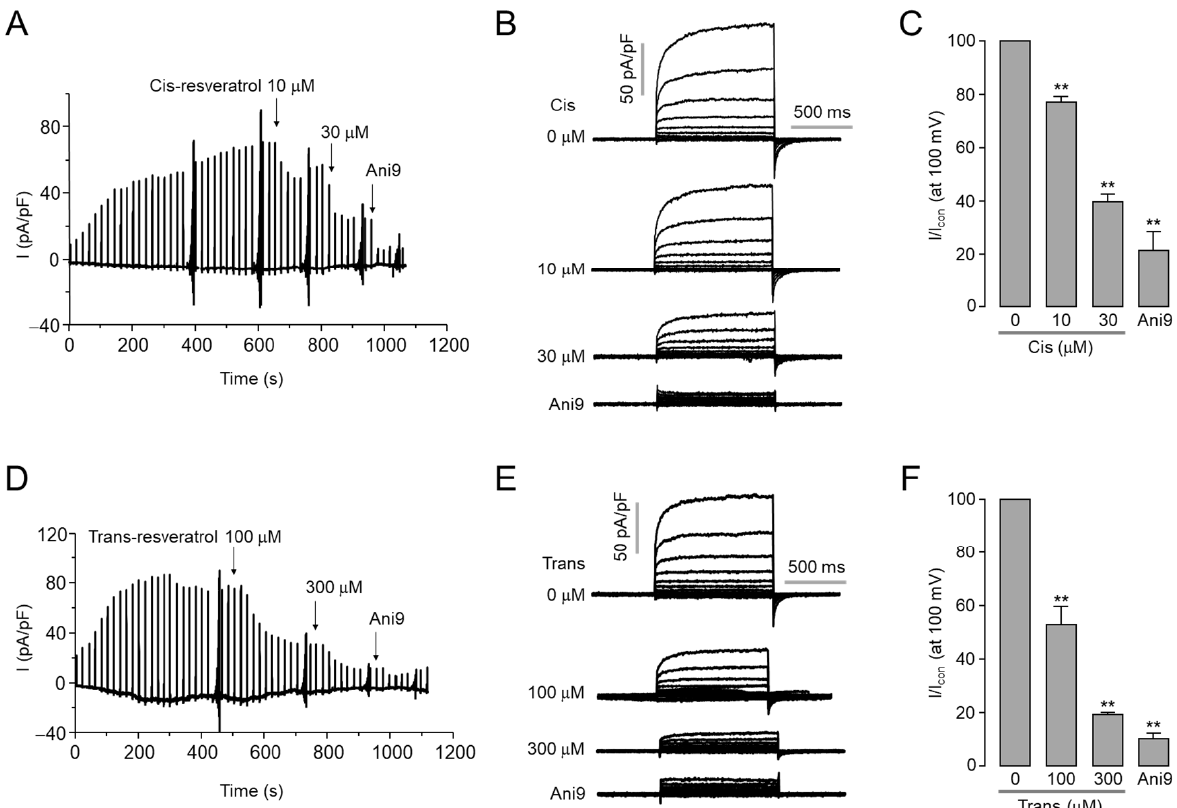
Figure 2. Cis - and trans -resveratrol inhibit ANO1 chloride currents. ( A ) Representative traces of whole-cell recordings of ANO1 in HEK293T cells expressing ANO1. Indicated concentrations of cis -resveratrol and 10 µ M Ani9 were treated after the activation of ANO1. ( B ) Whole-cell currents were recorded at a holding potential of − 60 mV and pulsed to voltages between ± 100 mV in steps of 20 mV. ( C ) Summary of current densities measured at +100 mV (mean ± S.D., n = 3–7). ( D ) Traces of whole-cell recordings of ANO1. Trans -resveratrol and Ani9 were treated as indicated after the activation of ANO1. ( E ) Whole-cell currents were recorded at a holding potential of -60 mV and pulsed to voltages between ± 100 mV in steps of 20 mV. ( F ) Summary of current densities measured at +100 mV (mean ± S.D., n = 3–7). ** p < 0.01 vs control.